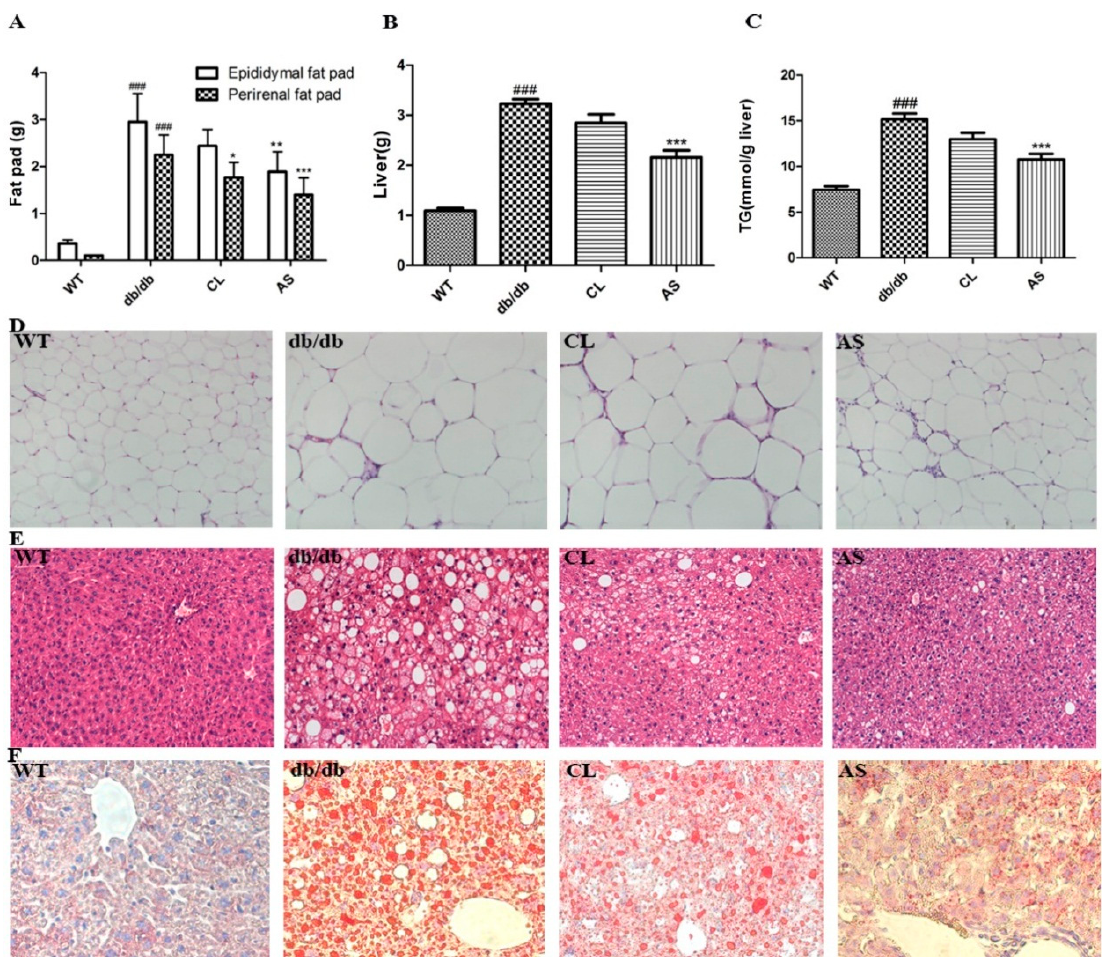
Figure 4. AS reduced adipose tissue, liver weight and hepatic lipid accumulation in db/db mice. ( A ) epididymal and perirenal fat pads; ( B ) liver weight; ( C ) hepatic TG was measured after mice had fasted for 12 h at the end of experiment; ( D ) epididymal adipose tissue and ( E ) liver were stained with hematoxylin and eosin; and ( F ) liver was stained with Oil Red O to detect the quantities of lipids. Images were acquired at 200× magnification by a microscopy. Values are expressed as mean ± SEM ( n = 6). * p < 0.05, ** p < 0.01, *** p < 0.001 vs. db/db group; ### p < 0.001 vs. WT group.